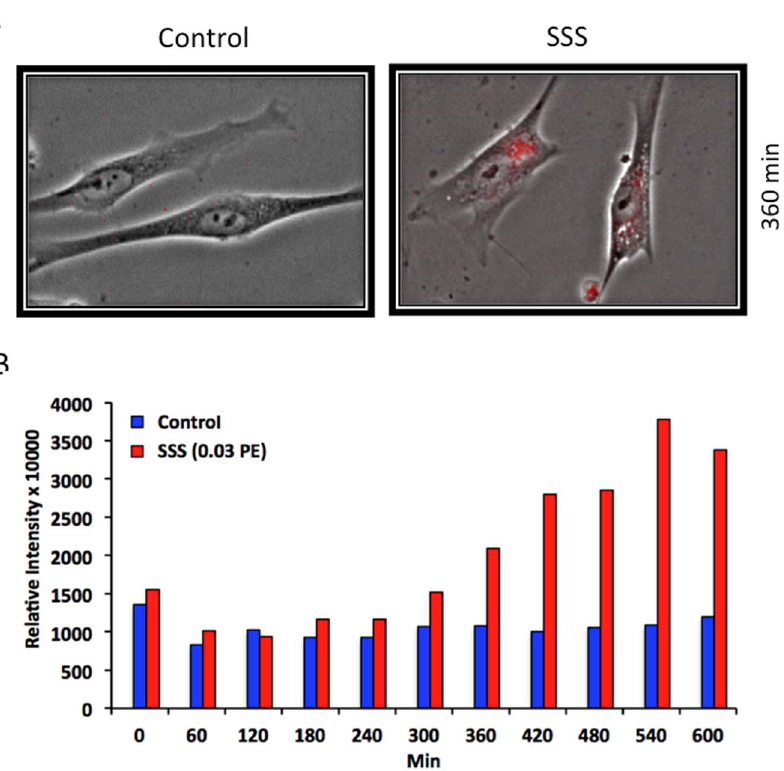
Figure 2. SSS increased ROS production in hPF. Cells were preloaded with MitoSOX TM Red to visualize ROS production. (A) Control cells imaged at 360 min did not have red fluorescence. (B) At 360 min, SS smoke treated cells had red fluorescence indicative of ROS production. (C) Bar graph showing increased intensity of fluorescence in treated cells, but not in control cells, over 600 min. In Figure 2C, data are the means of two experiments; the control and treated groups had 84 and 99 cells,